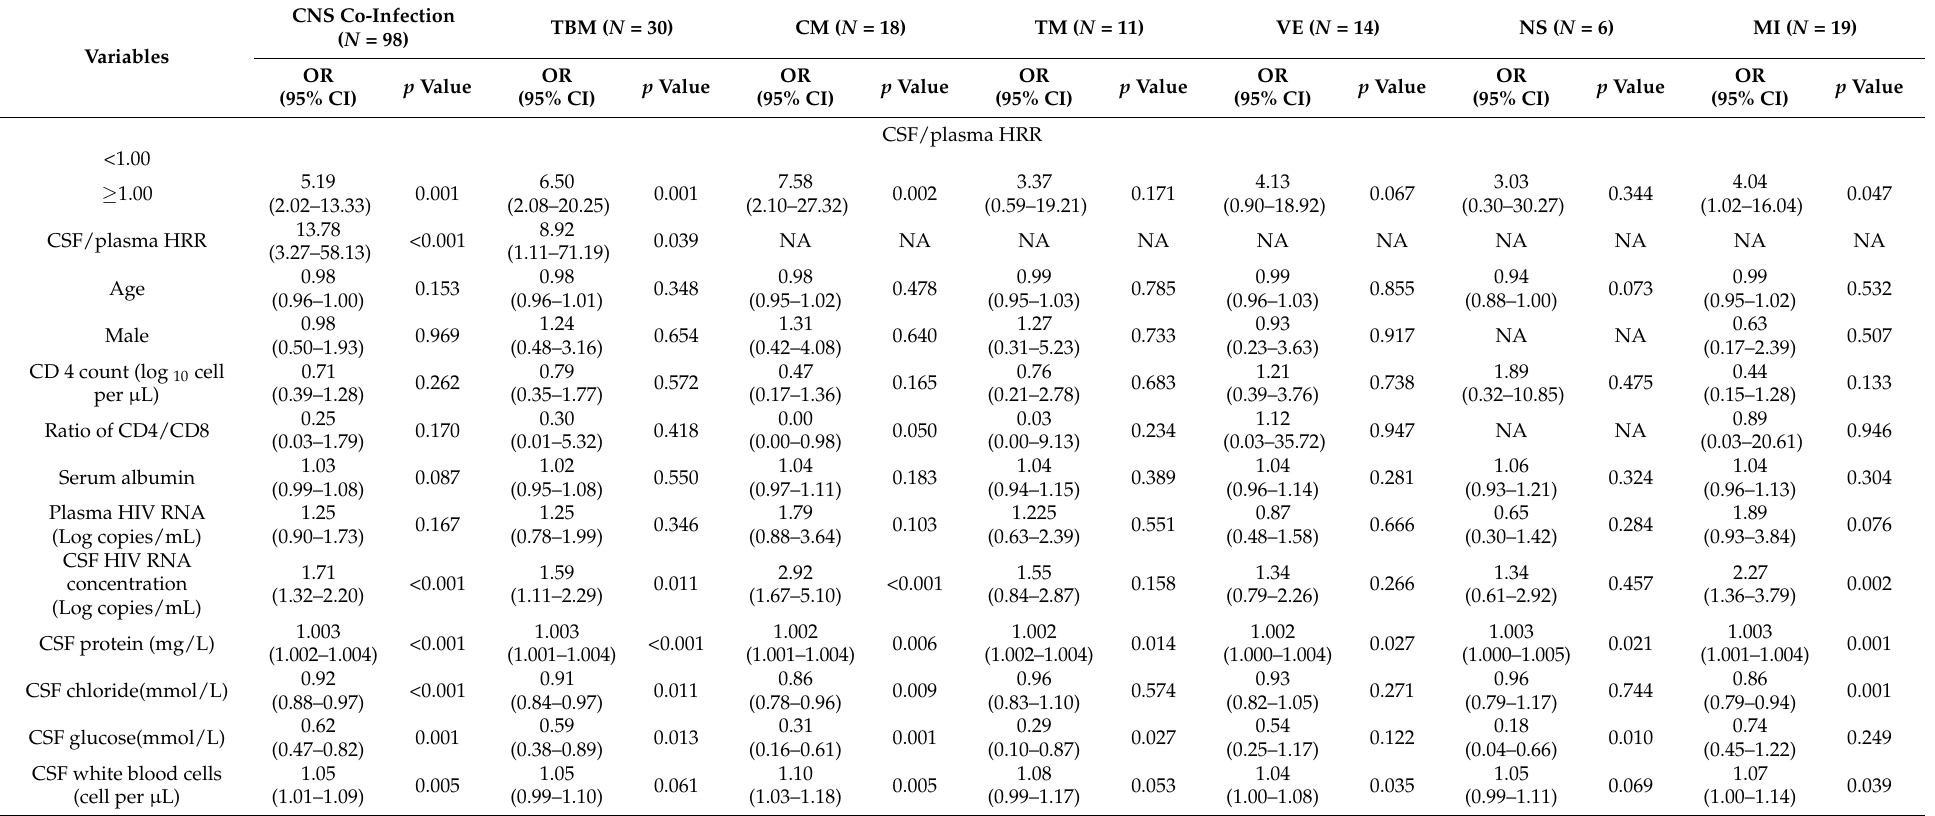
Table 2. Univariate analyses to identify risk factors for different types of central nervous